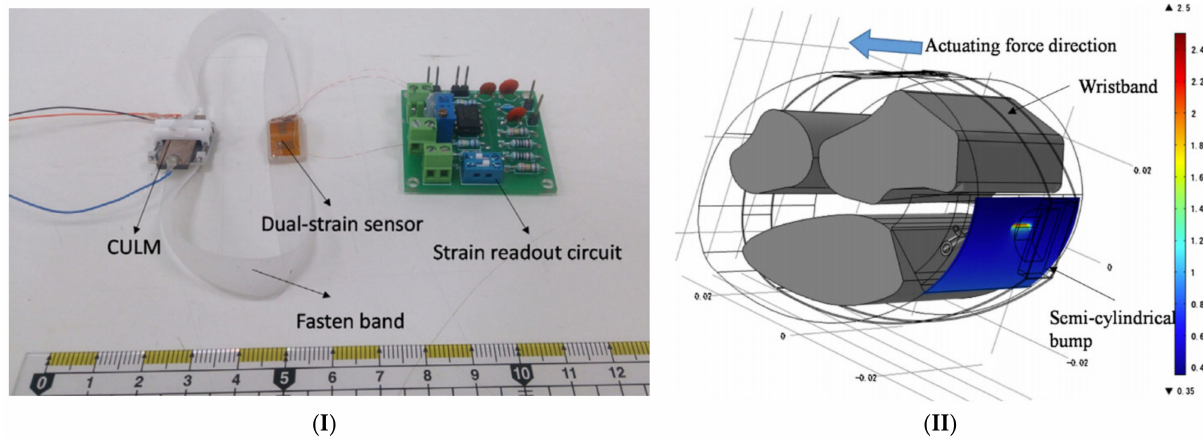
Figure 7. Printed blood pressure monitoring devices from the literature. ( I ) Strain gauges sensor by Wang et al. [294] showing CULM and strain sensor, ( II ) displacement simulation on the skin as a result of the actuation force. Reused with permission, Copyright (2016),